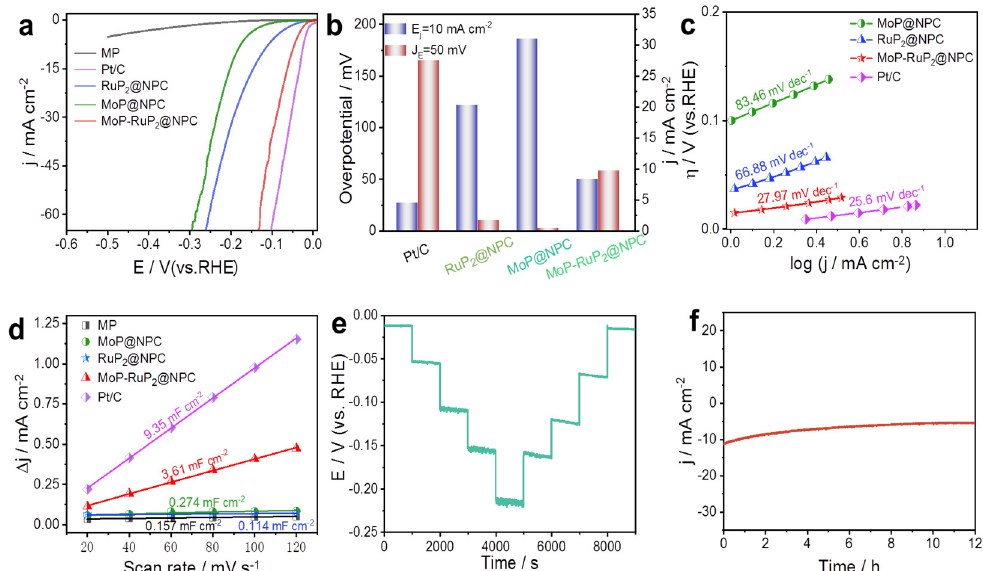
Figure 3. ( a ) LSVs of Pt/C, MoP-RuP 2 @NPC, MoP@NPC, RuP 2 @NPC and MP for the HERs with a scanning rate of 5 mV s − 1 in 1 M KOH. ( b ) Summarized overpotentials (current density of 10 mA cm − 2 ) and the current density (overpotential of 50 mV vs. RHE). ( c ) Tafel slopes and ( d ) Cdl of the obtained nanomaterials. ( e ) Multistep chronoamperometric curves of MoP-RuP 2 @NPC at various applied overpotentials in 1 M KOH. ( f ) Long-term stability study of the prepared electrocatalyst for 12 h.